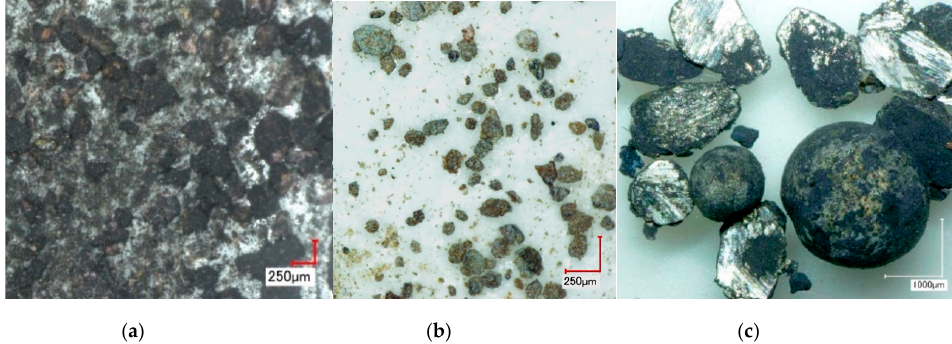
Figure 5. Optical images of the CD6-2 ( a ), CD6-5 ( b ) and CD6-6 ( c ) fractions at magnifications 200×, 150× and 50×, respectively.